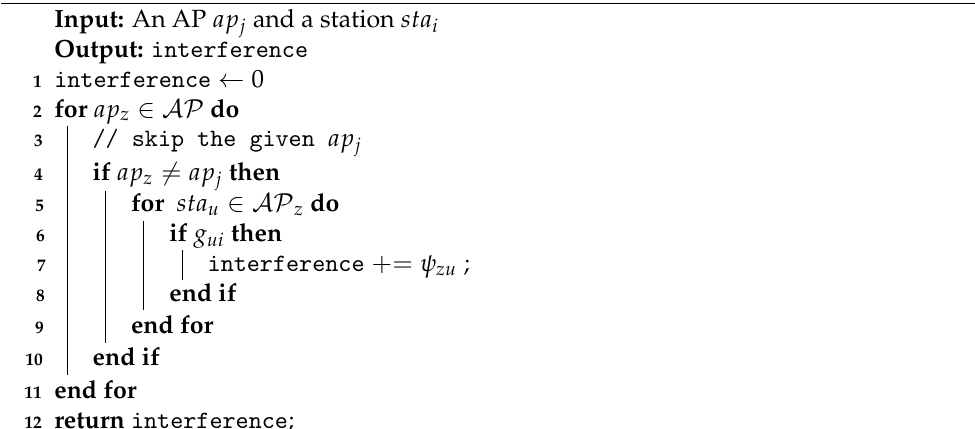
Algorithm 1: Procedure describing function I ( ap j , sta i ) in Equation (3)